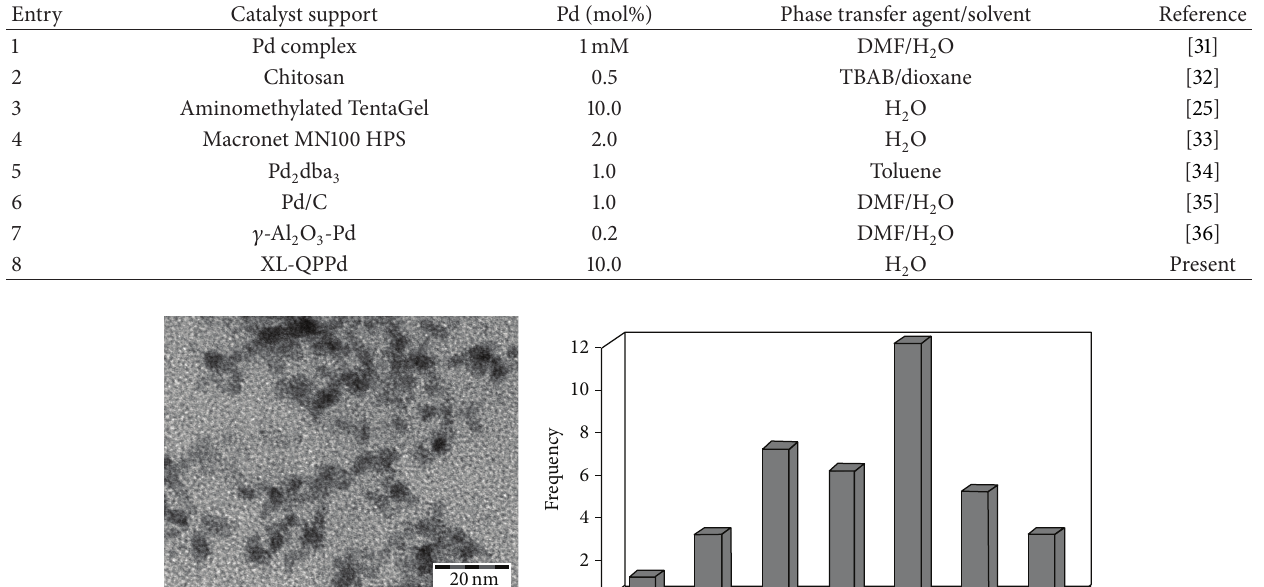
Table 2: Comparison with other catalyst systems.